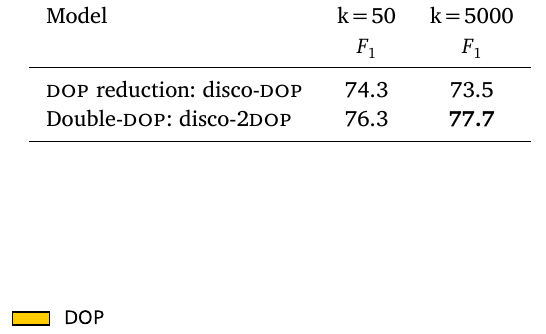
Average time spent in each stage for sentences